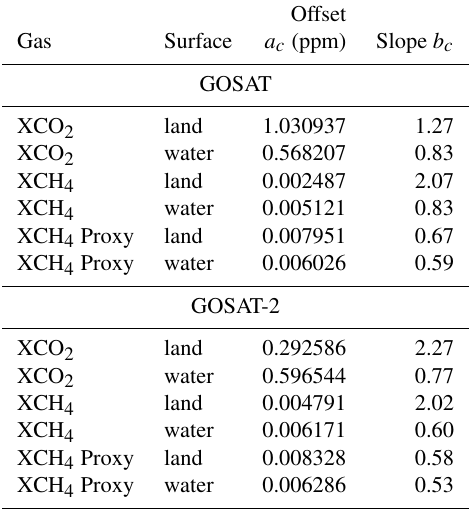
Table 5. Coefficients of linear uncertainty